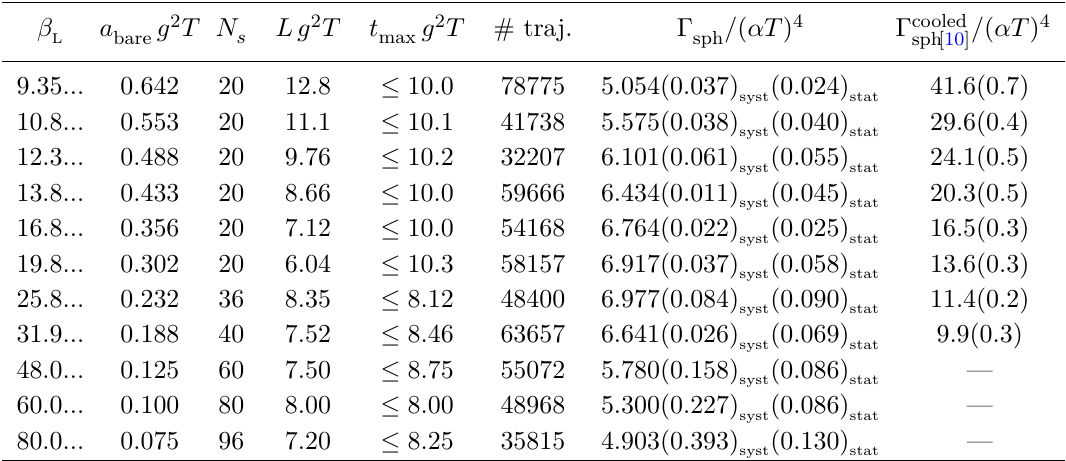
Table 2 . Like table 1 but for N = 3 . In this case the cooled rates originate from table 3 of ref. [10], c after undoing the improvement employed in that